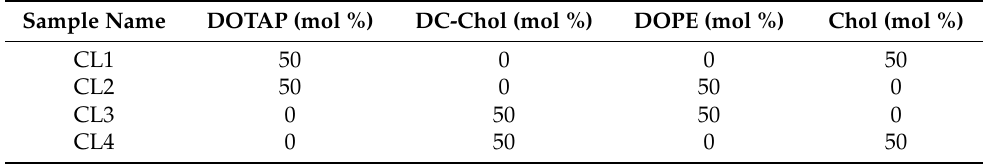
Table 1. Lipid compositions of TMZ-loaded